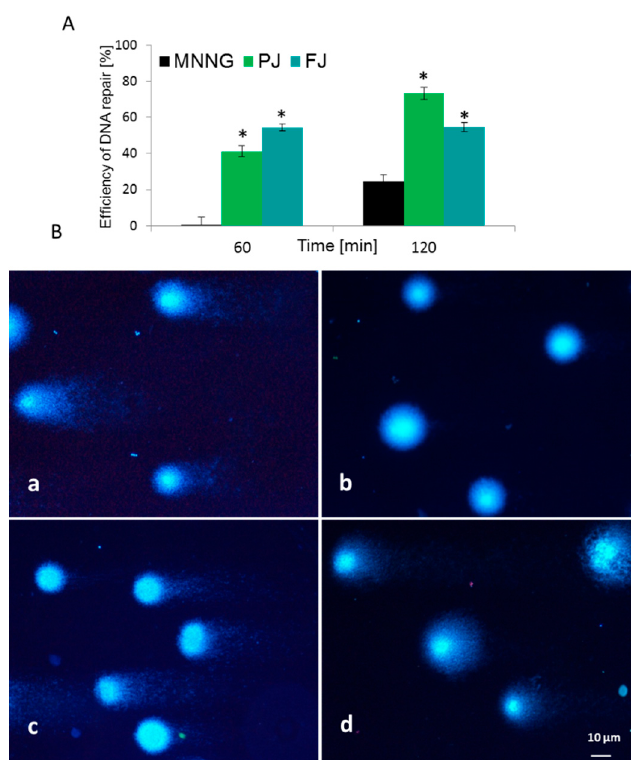
Figure 8. Efficiency of DNA repair (%) in Saos-2 cells exposed to MNNG mutagen and post-incubated with V. opulus FJ and PJ at IC 0 concentration ( A ). Typical images of comets stained with DAPI ( B ): ( a ) 6.8 µ M MNNG; ( b ) negative control on untreated cells; ( c ) PJ influence after 60 min and ( d ) 120 min of post-treatment. Fluorescence microscopy (Nikon, Tokyo, Japan); × 200 magnification. * p ≤